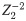
RMS astigmatism (Z2−2 and Z22) values of the designed IOLs for misalignment (left column) and tilt (right column) with each different cornea: A) Normal, B) Myopic, C) Hyperopic.